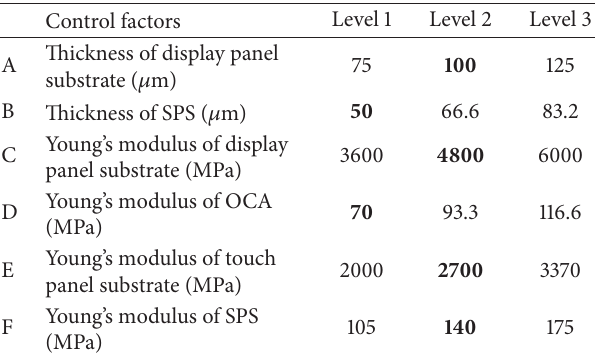
Table 3: Design parameters and their